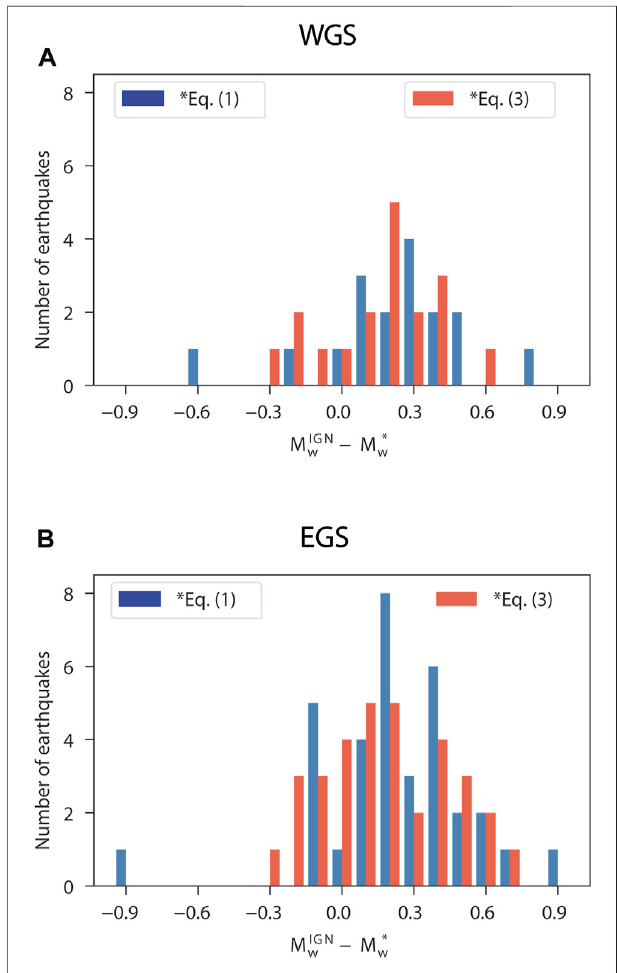
FIGURE 7 | Differences between the IGN and EEWS magnitude estimations for earthquakes that occurred in the western Strait of Gibraltar (A) and the eastern Strait of Gibraltar (B)